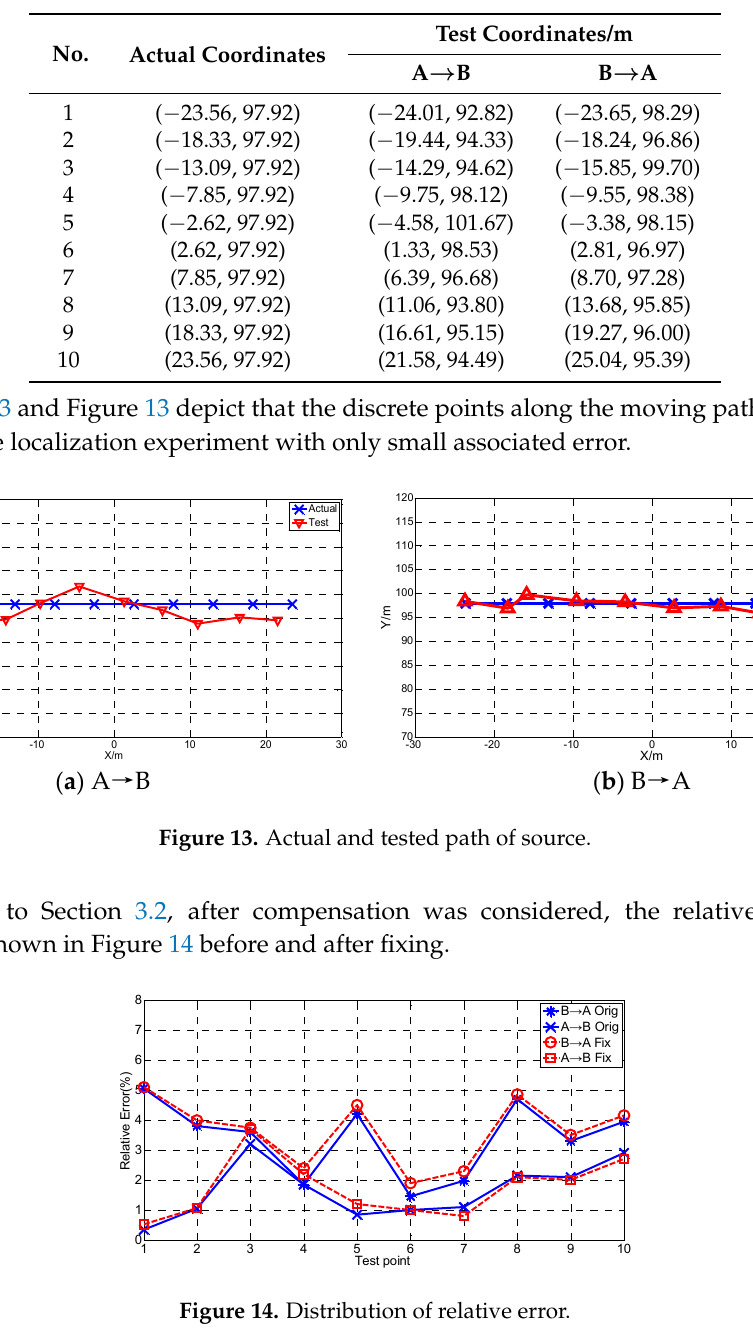
Table 3. Locating result of moving source.